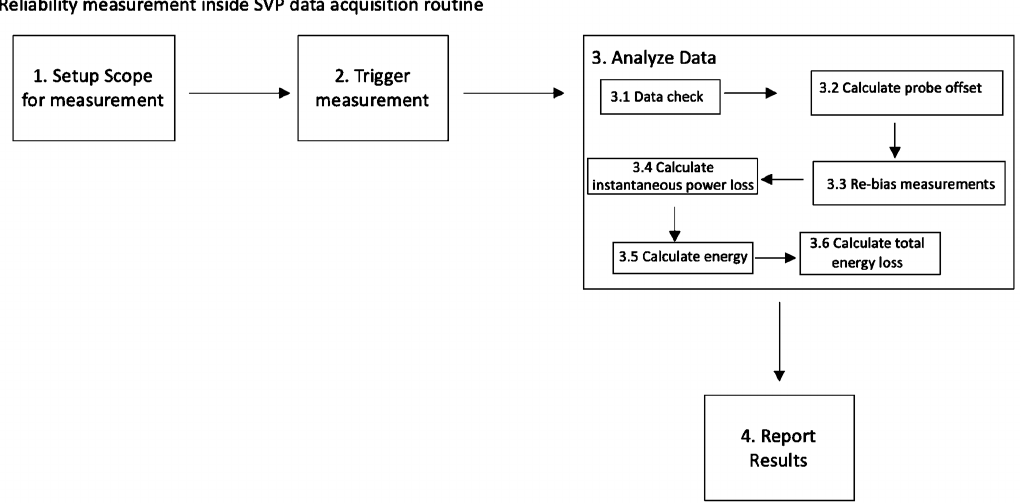
Figure 4. Script to calculate switching loss within SVP.